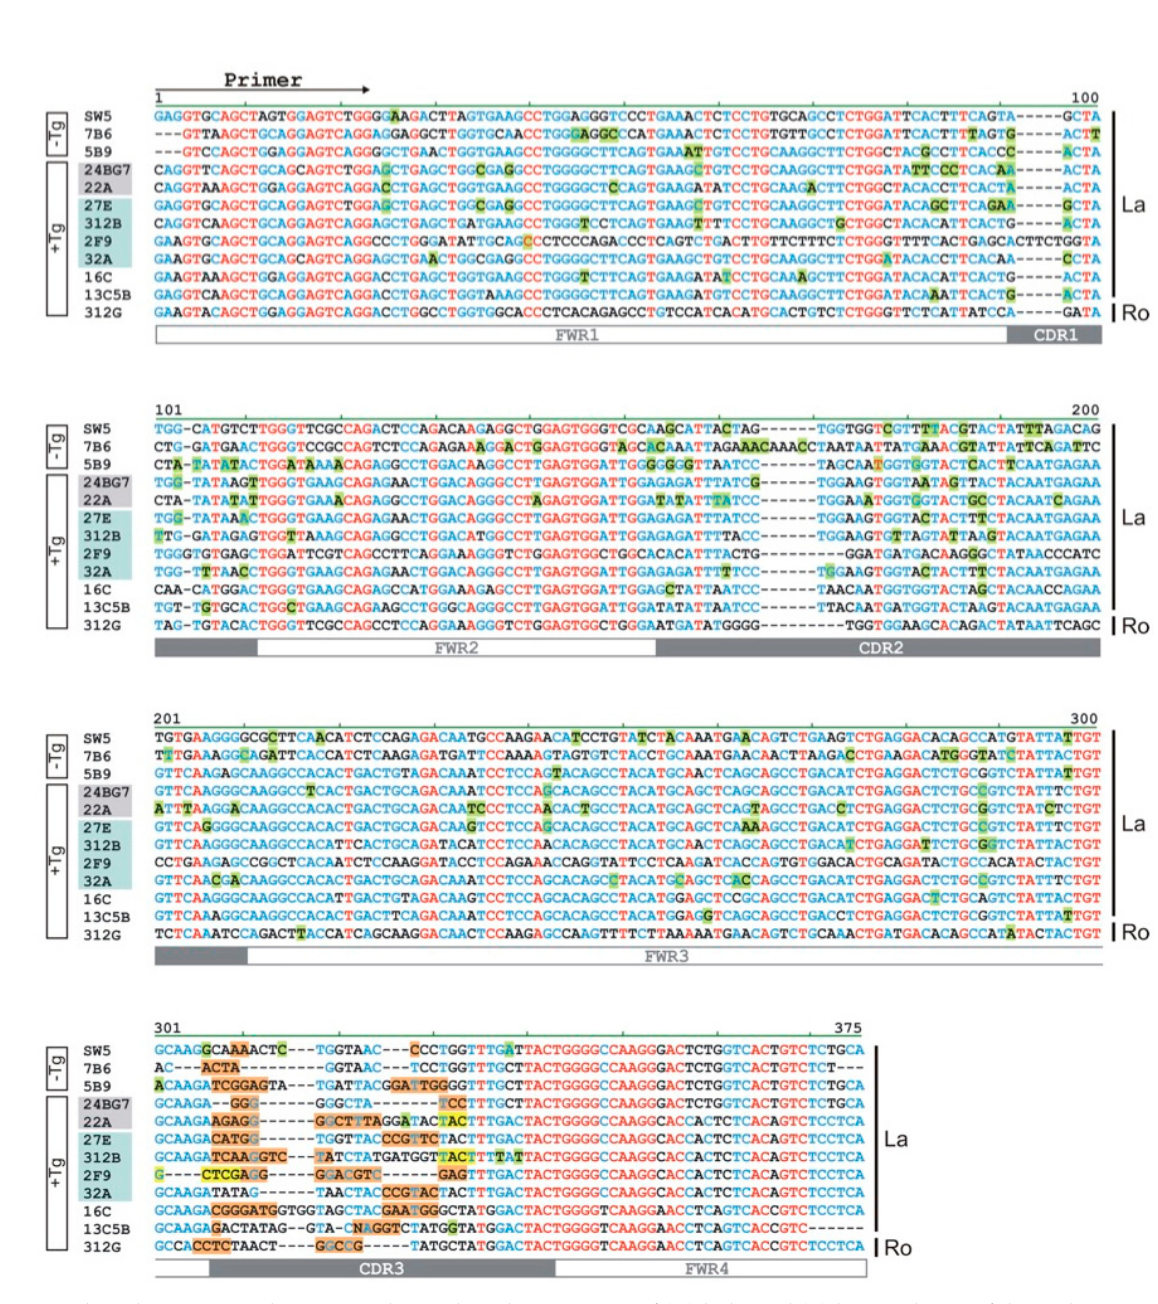
Figure 3. Nucleotide sequence alignment. The nucleotide sequences of ( A ) light and ( B ) heavy chains of the mabs were estimated and aligned. The -Tg sequences of the previously established non-transgenic hybridomas (SW5, 7B6, and 5B9). The +Tg sequences of the mabs established from the human La transgenic mouse including the Group 1 anti-La hybridomas (highlighted in grey), Group 2 anti-La hybridomas (highlighted in blue), as well as the IgM type mabs positive in ELISA against recombinant La protein (16C and 13C5B) or Ro60 (312G). FWR, framework region; CDR, complementarity determining region; Primer, forward primer used for PCR. Sequence differences in the primer region were not included for evaluation of somatic hypermutations as these differences may be derived from the used degenerated primers. Somatic mutations leading to aa replacements are highlighted in green.